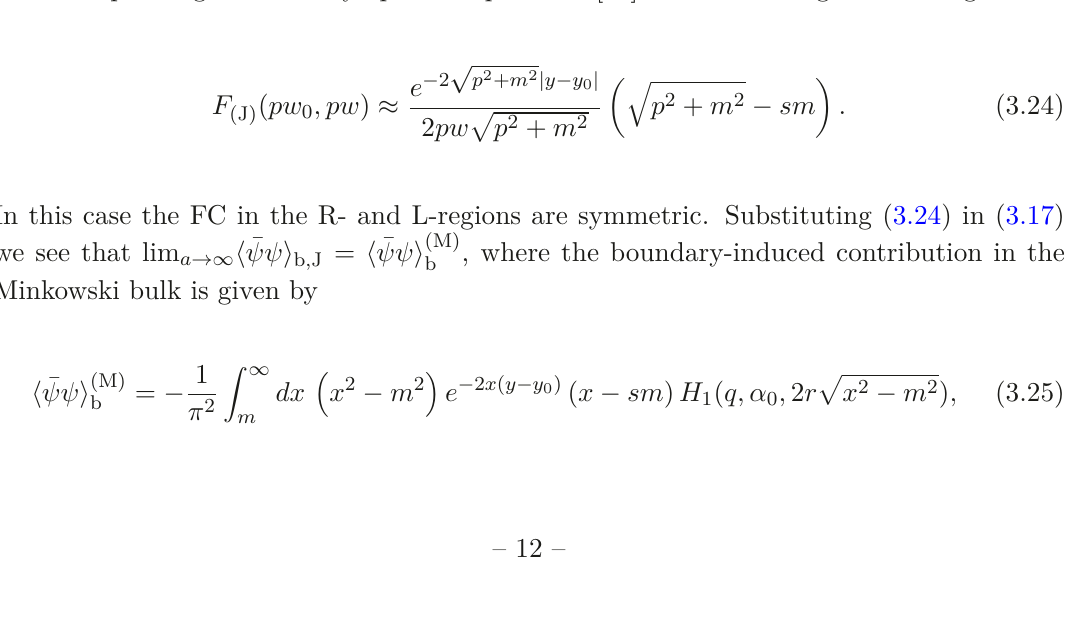
1. The graphs are plotted −